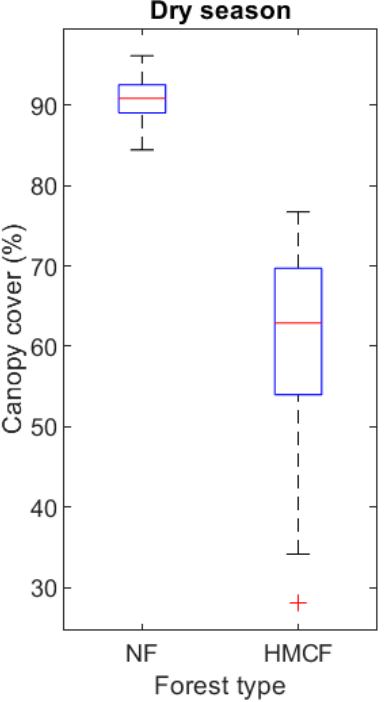
Figure 4. Tree canopy cover fraction from undisturbed NF and HMCF. The number of canopy photos analyzed in NF and HMCF is 43 and 85, respectively. The mean (SD) of canopy cover in NF and HMCF is 90.8% (2.7%) and 61.4% (10.4%), respectively.